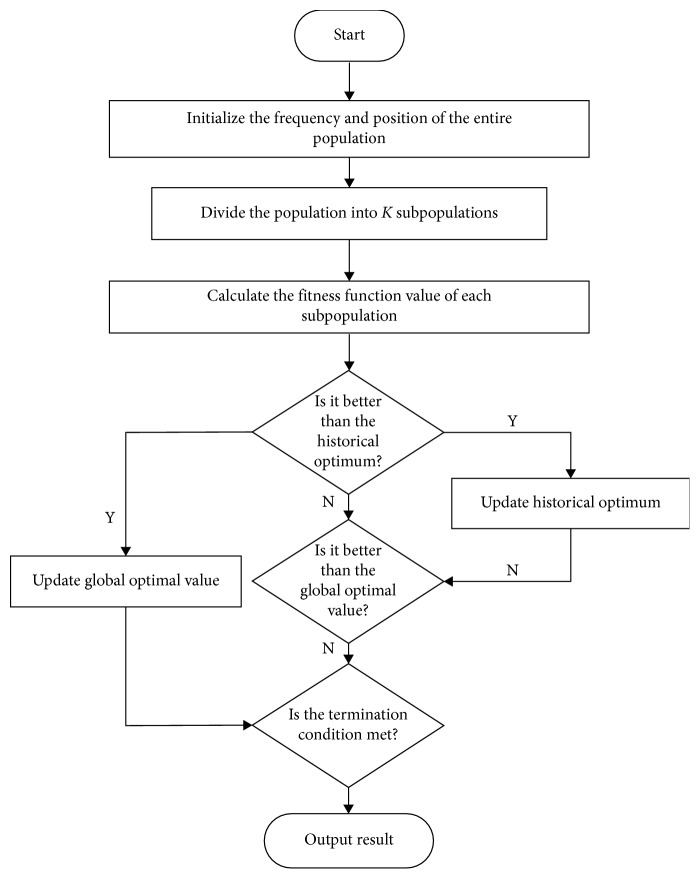
Bat algorithm flow chart based on island model.